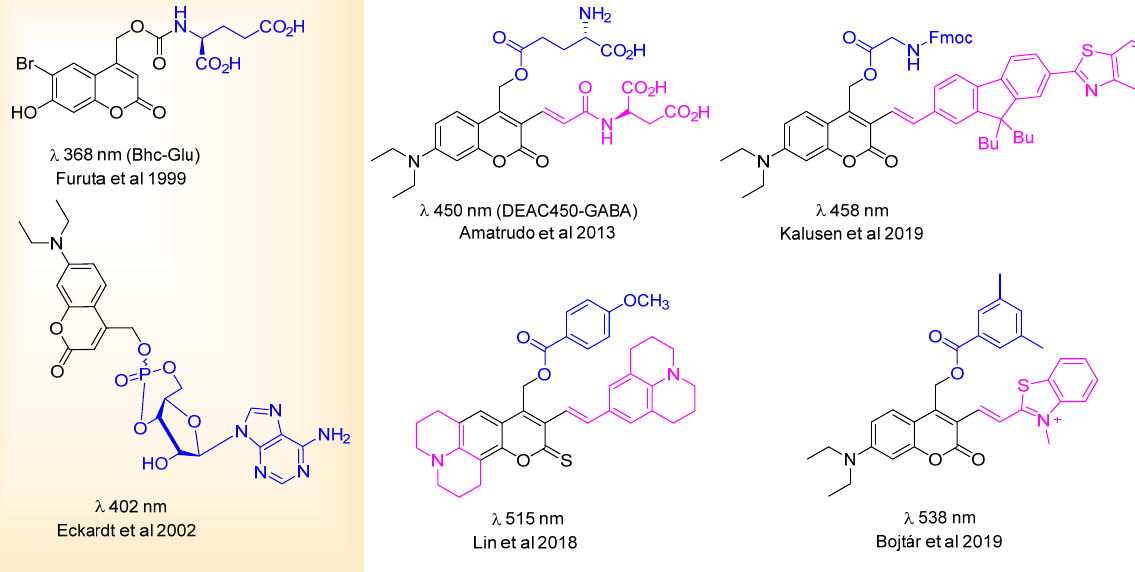
Figure 5. A selection of modified coumarin PPGs operating at higher wavelengths [45–48]—with the parent coumarin PPG structures shown in the left panel, the cargos indicated in blue and the structural modifications vs. the parent structures [49,50] in violet.